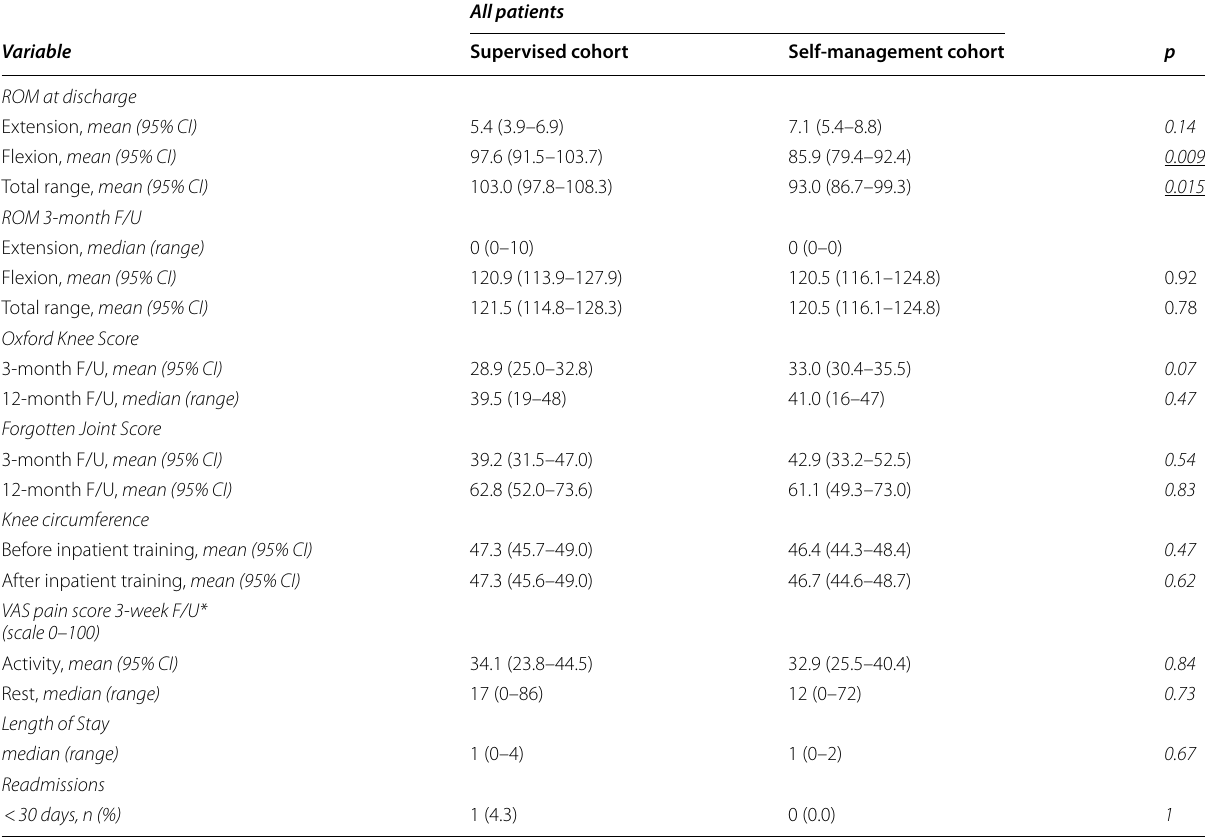
Table 2 Outcomes for supervised- and self-management